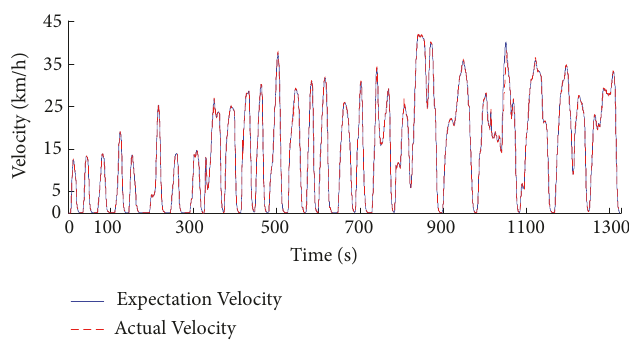
Figure 14: Comparison of speed tracking curve.